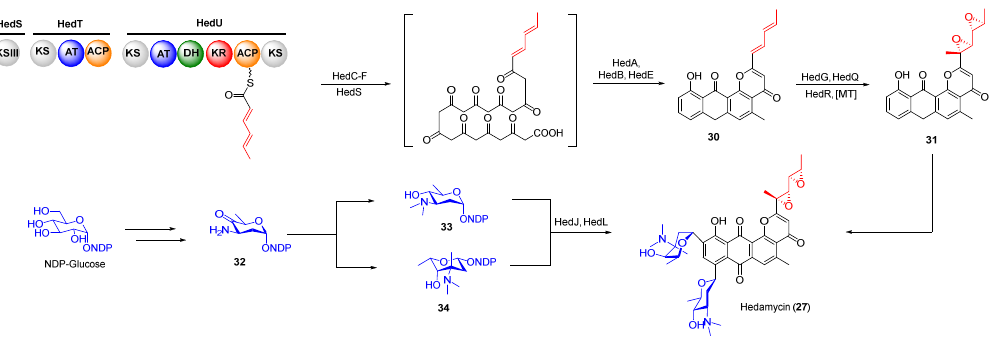
Figure 7. Proposed biosynthetic pathway of hedamycin. KS, ketosynthase; KR, ketoreductase; ACP, acyl carrier protein; DH, dehydratase; AT, acyl transferase.